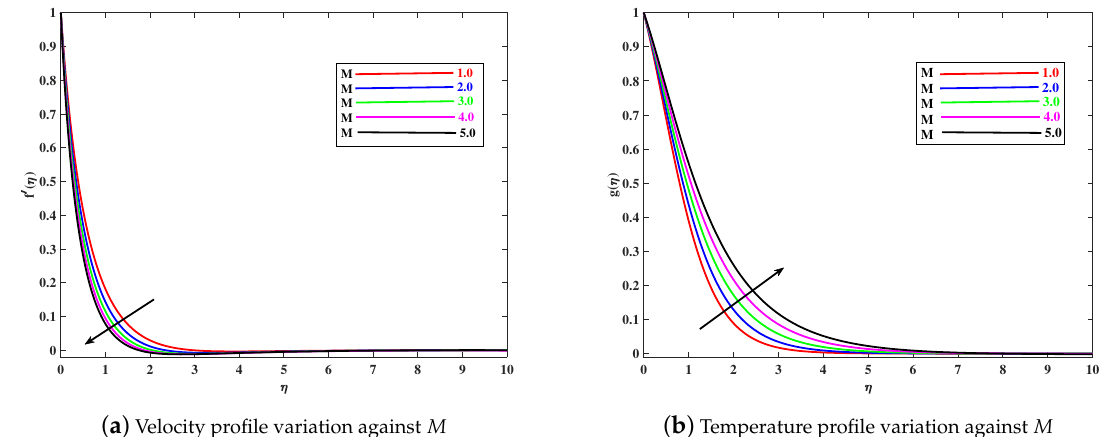
Figure 2. Effect of M to influence the momentum and thermal profile.